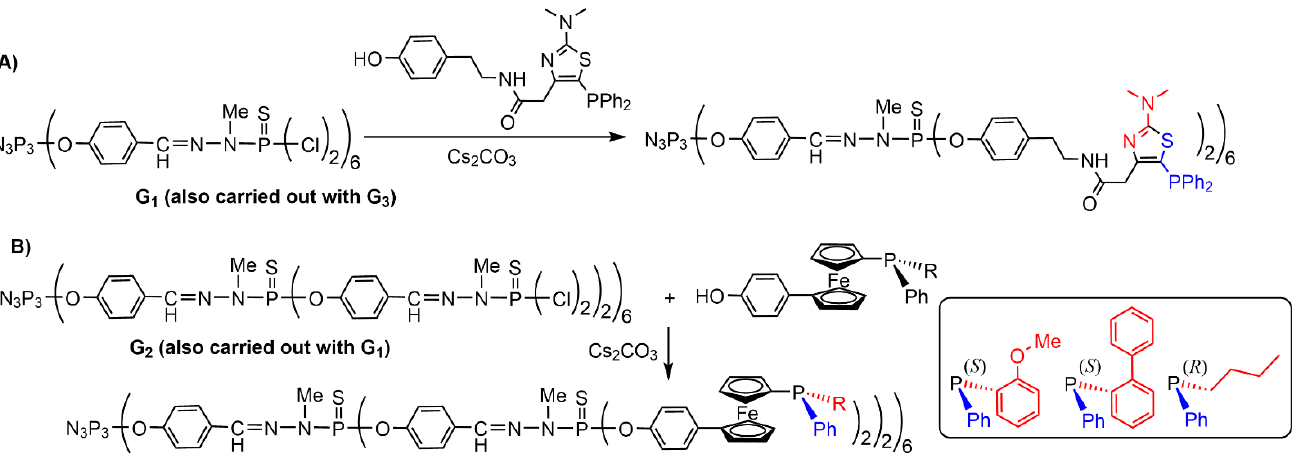
Scheme 4. Synthesis of dendrimers functionalized with thiazolyldiphenylphosphine for which the Pd complex was used in Suzuki couplings ( A ) and chiral ferrocenylphosphines for which the Ru complexes were used in switchable transfer hydrogenations ( B ).